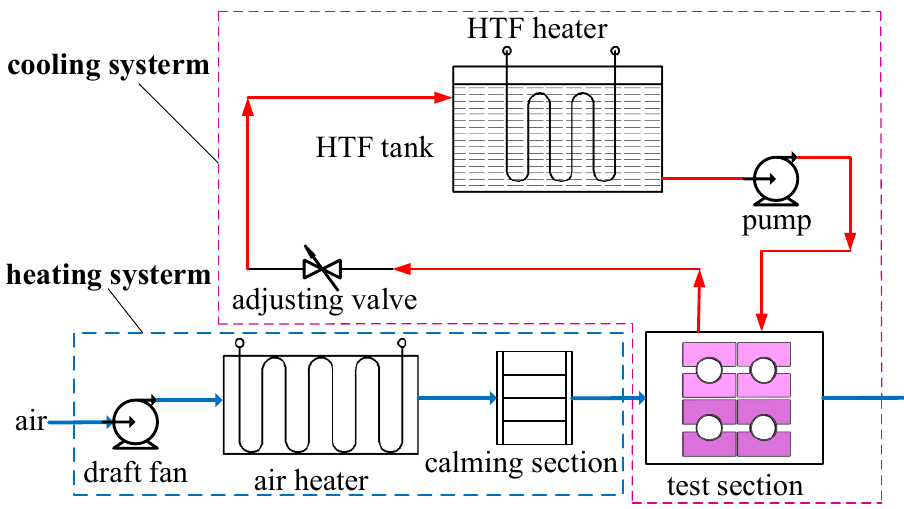
Figure 1. Schematic diagram of the experimental system.